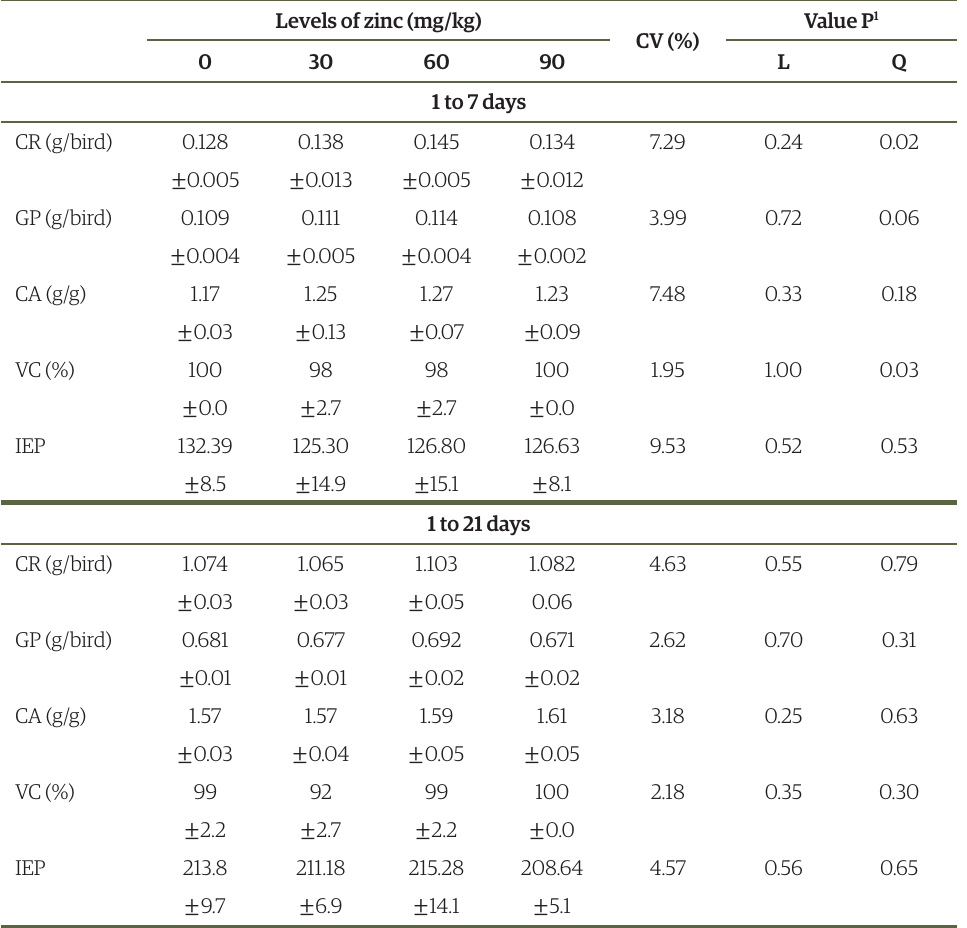
Table 3. Performance of broiler chickens from 1 to 7 and from 1 to 21 days old, fed with organic zinc levels CR - feed intake; GP- weight gain; CA- feed:gain ratio; CV- creative viability; IEP- productive efficiency index 1 L - linear effect, Q - quadratic